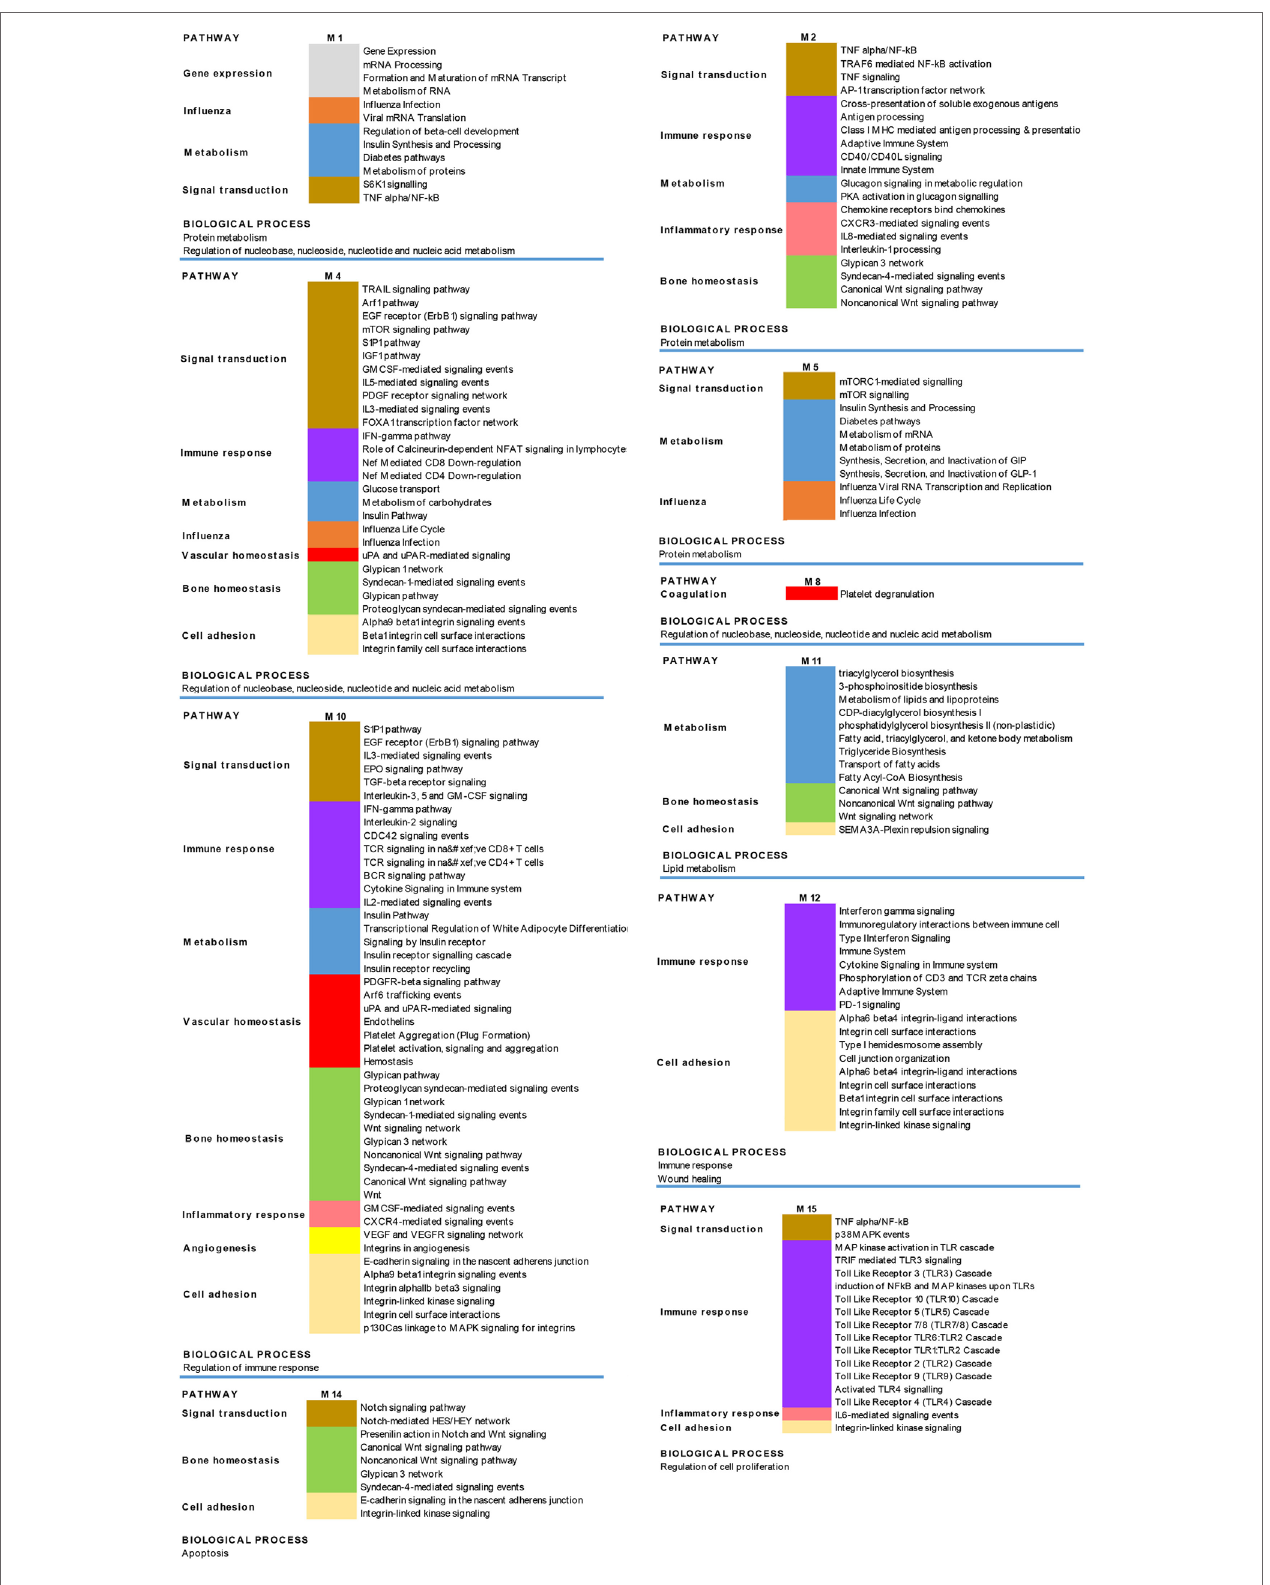
FigUre 6 | Biological processes and pathways enrichment analysis of the targeted modules. Selection of the different enriched pathways ( p < 0.05) in the 10 targeted modules (M). Pathways that are enriched in more than one module are labeled by the same color in the different